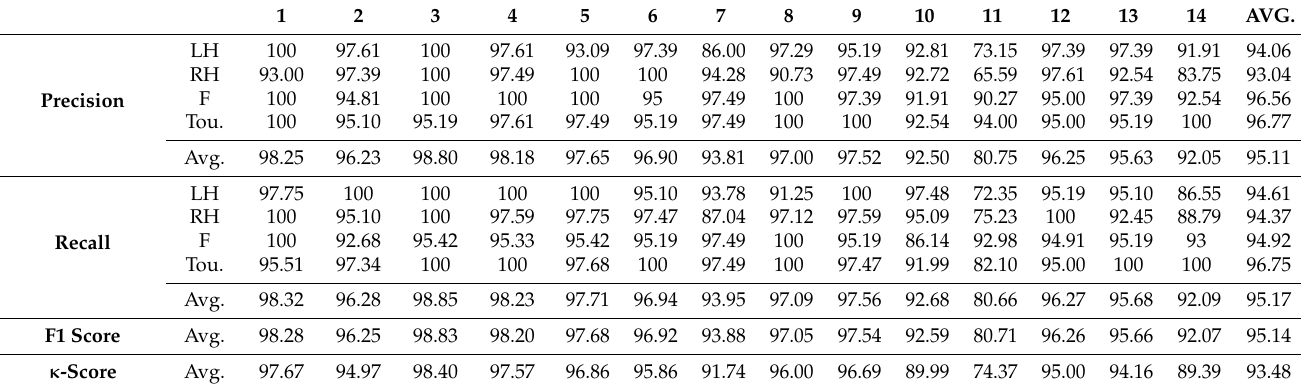
Table 10. Precision, recall, F1 score, and κ -score on the HGD using